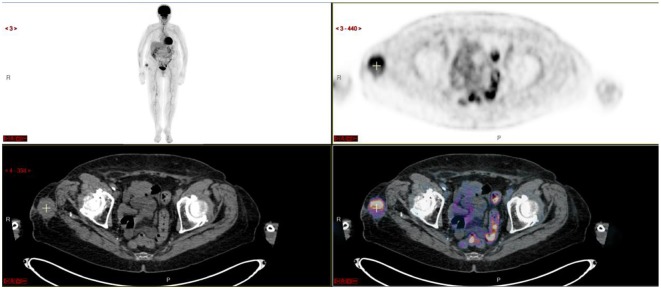
Extra-medullary disease histologically proven in this subcutaneous mass.